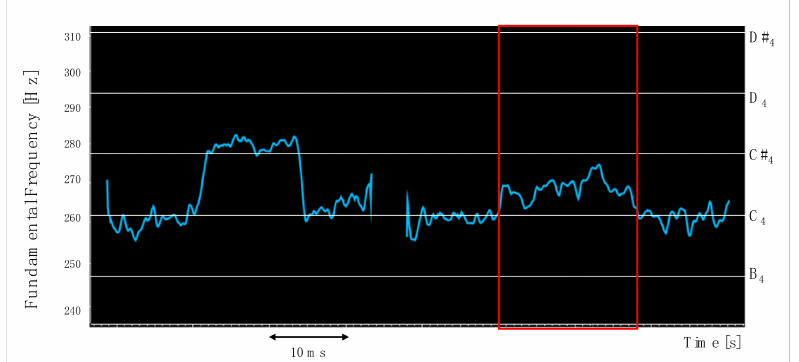
Figure 20. VoceVista Video Pro software display of a male singer practicing micro-intonation between pitches C4 and C#4, marked within the red